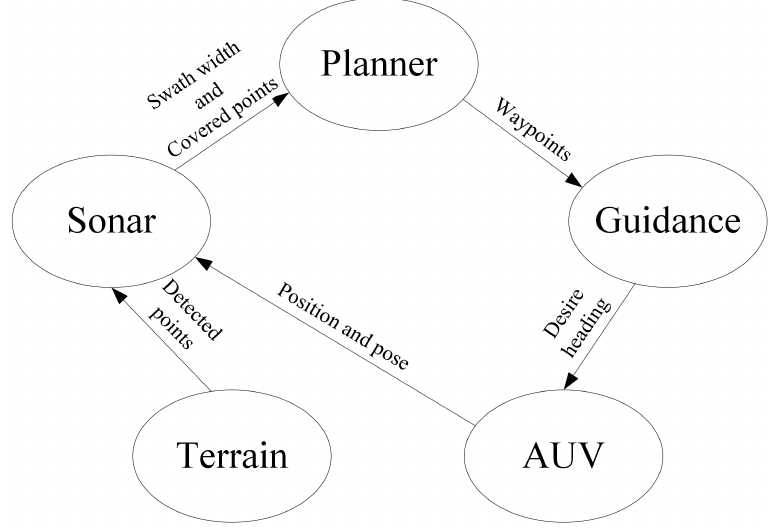
Figure 5. Structure of the